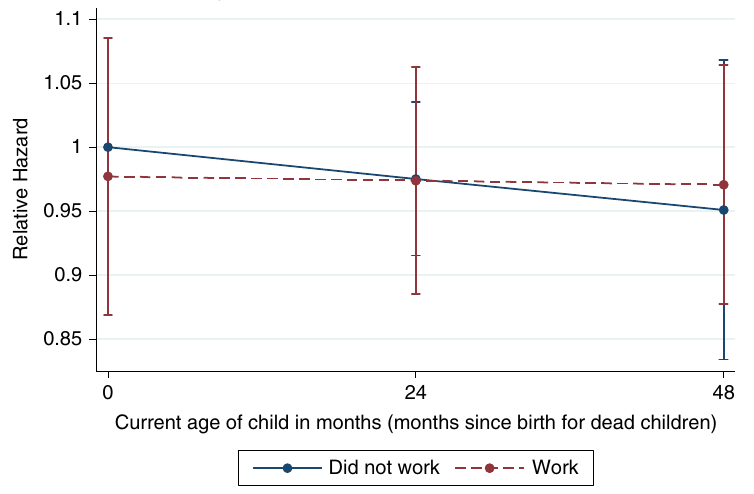
Figure 1. Predication of